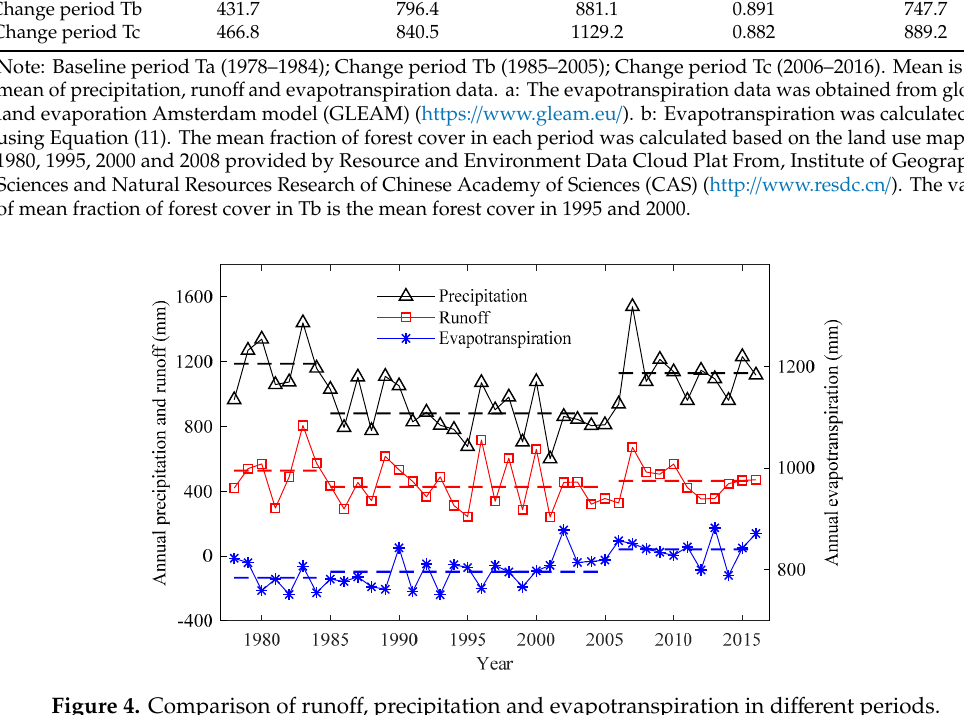
Figure 4. Comparison of runoff, precipitation and evapotranspiration in different periods.